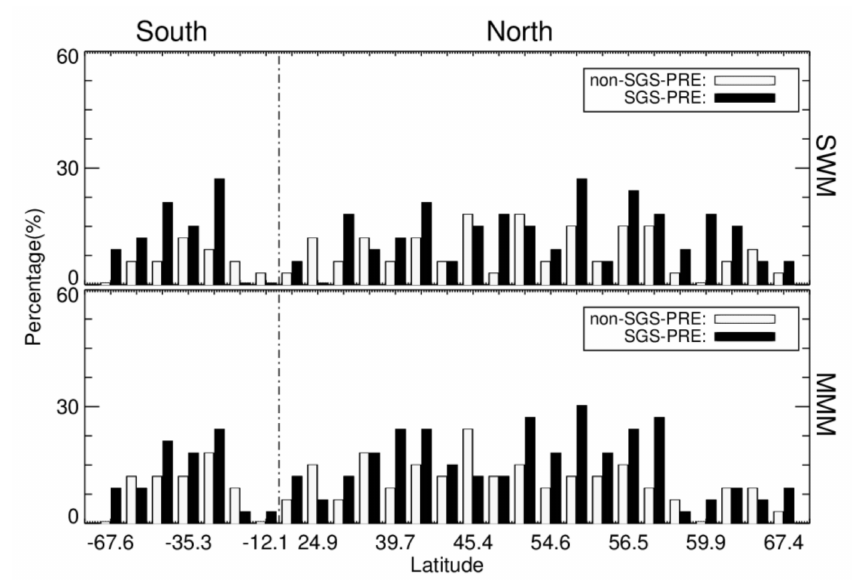
Figure 5. Latitudinal distribution of ionospheric weak response events with and without super geomagnetic storm with a preceding storm event (SGS-PRE) as a percentage of all super geomagnetic storm (SGS) events. Black (white) bars denote the percentage of ionospheric weak response with (without) SGS-PRE events. The upper panel is the result derived by the spectral whitening method (SWM), and the lower panel is derived by the monthly median method